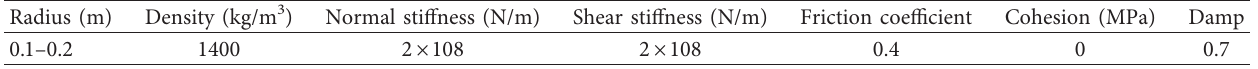
Table 6: Parameters for granular coal.